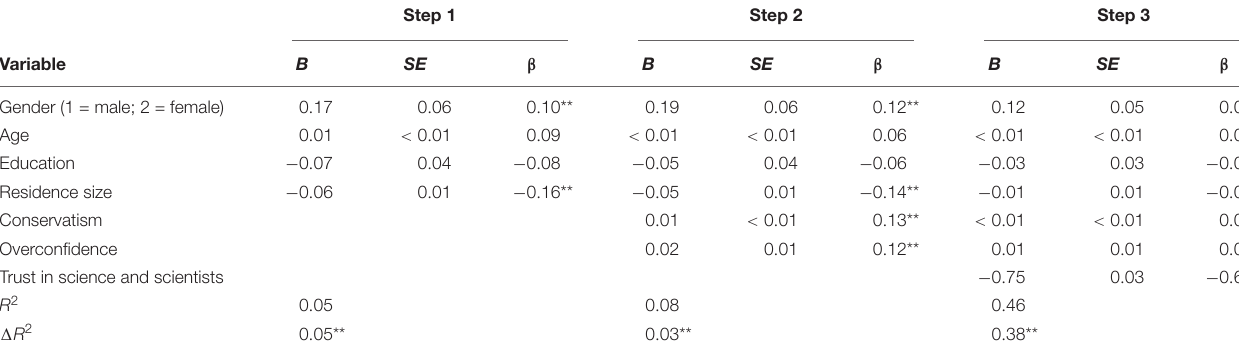
TABLE 2 | Summary of the three-step hierarchical regression analysis for variables predicting beliefs in COVID-19 conspiracy